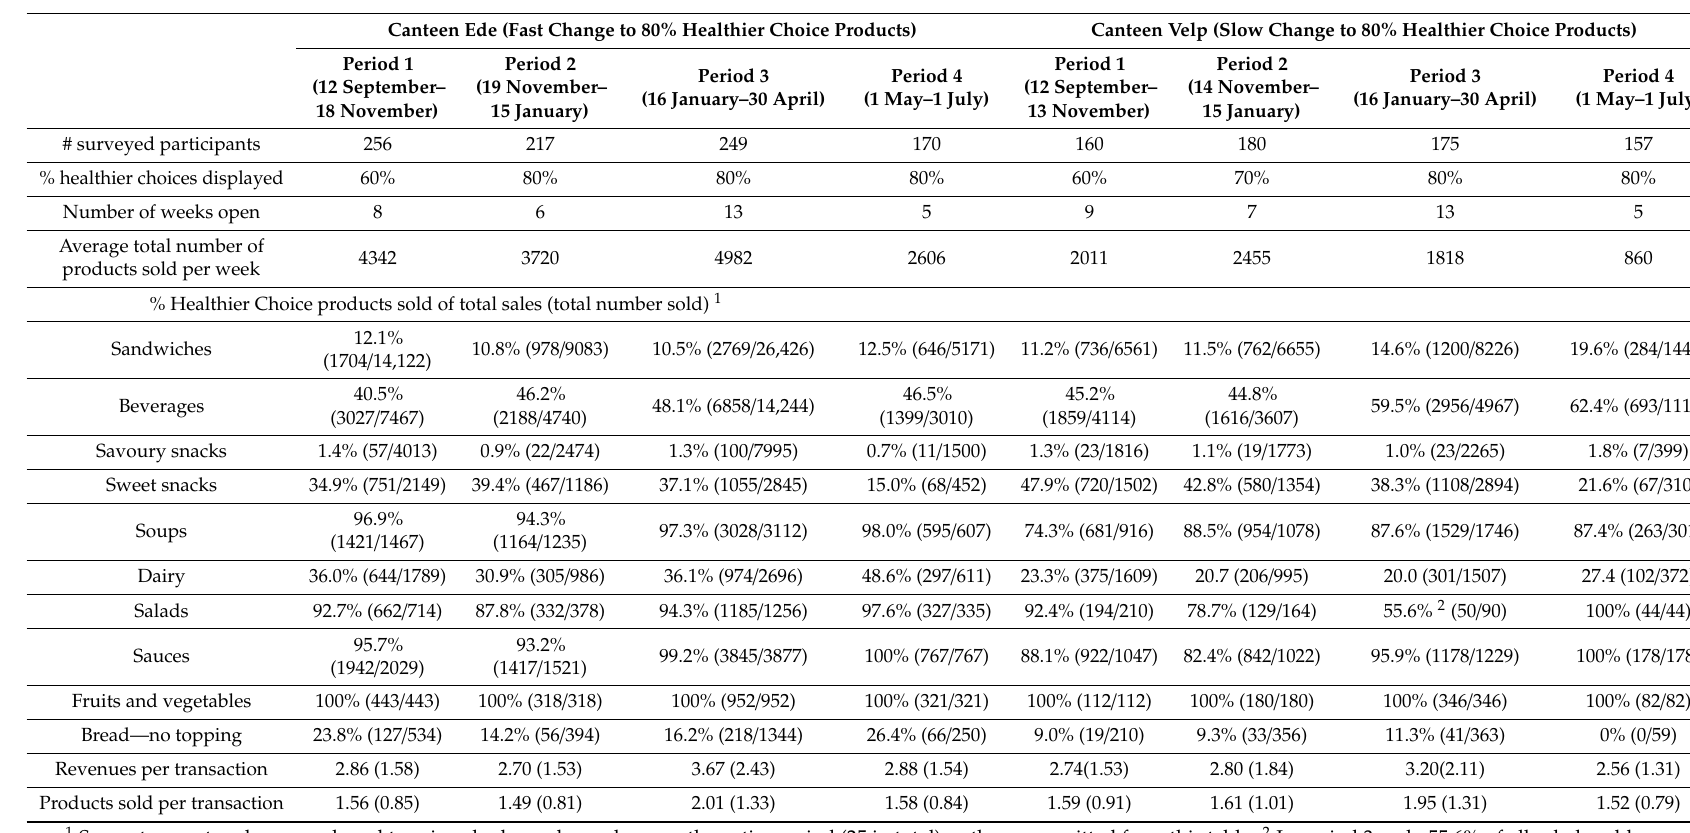
Table 2. Descriptives of experimental design, sales, revenues and number of surveyed participants in each of the four periods in the two